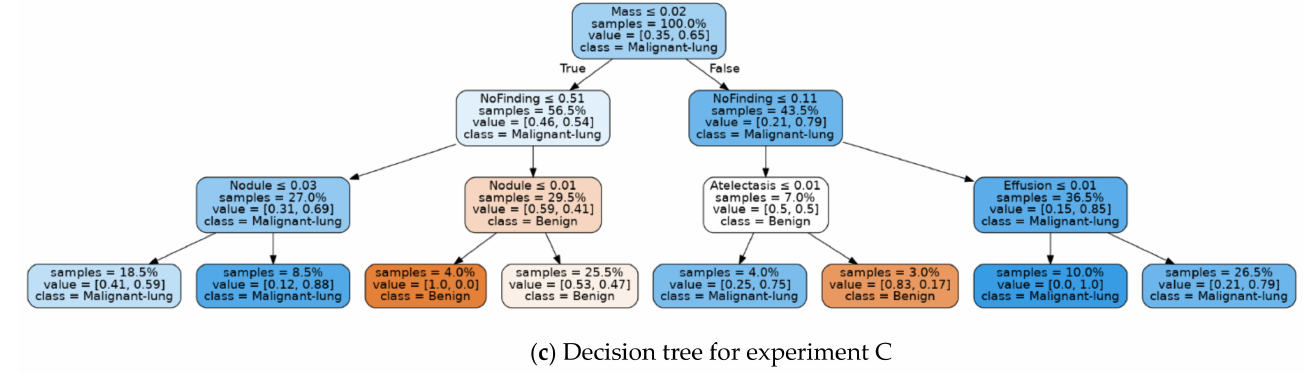
Figure 13. Best fit trees for combined LIDC-IDR and JSRT inferencing datasets for experiments A, B, C and D. The model for experiment A shown as Figure 13a indicates that a high score for “Nodule” with the presence of Effusion is associated with malignancy